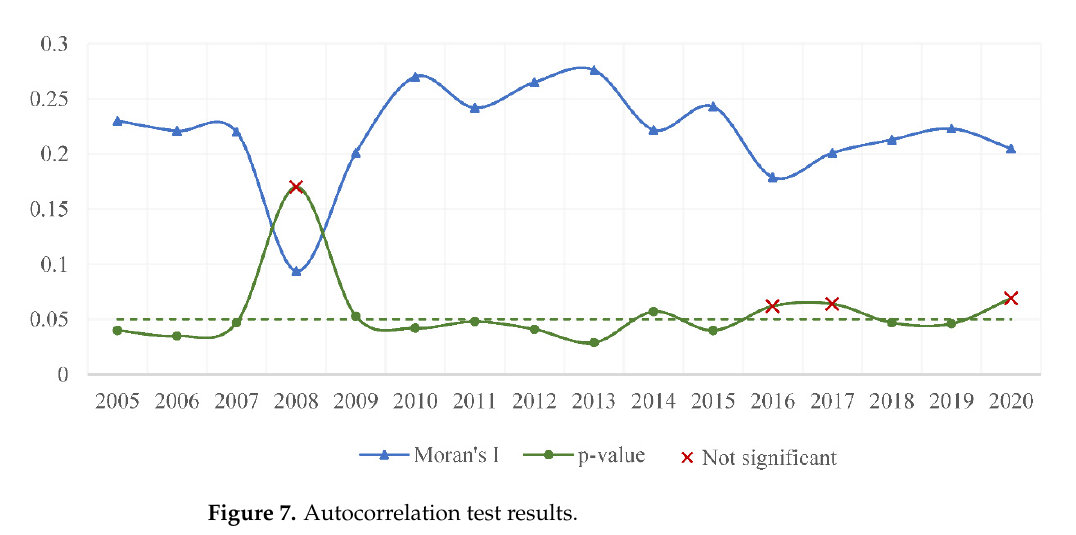
Figure 6. Spatial and temporal distribution of carbon emissions from marine fisheries in 11 coastal provinces of China; the graphs represent 2005 ( left ), 2012 ( middle ), and 2020 ( right ), respectively.